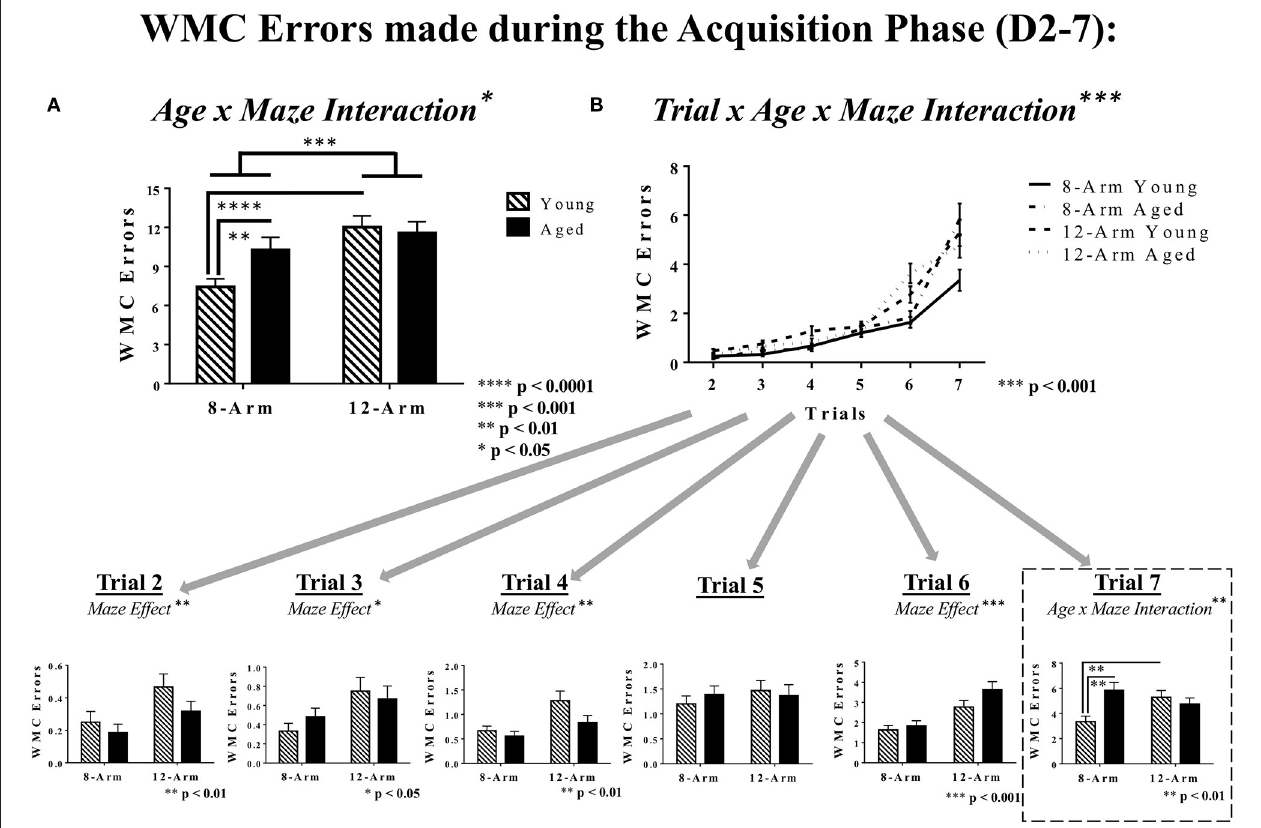
FIGURE 3 | WMC errors during the Acquisition Phase of WRAM testing. (A) WMC errors for the Acquisition Phase of WRAM testing (Days 2–7). With an effect of Maze and an Age × Maze Interaction, it was found that within the 8-Arm WRAM there was an effect of Age, but not for the 12-Arm WRAM; additionally, young rats tested on the 8-Arm WRAM performed better than those tested on the 12-Arm WRAM, but performance across maze did not differ for aged rats. (B) Working memory performance as measured by WMC errors made across all testing trials (Trials 2–7). At the highest working memory load (Trial 7), there was an Age × Maze interaction, where aged rats performing on the 8-Arm WRAM made more errors than their younger counterparts, and the rats performing on the 12-Arm WRAM did not differ by age. Additionally, for young rats there was an effect of Maze, where rats tested on the 8-Arm WRAM made fewer errors than their counterparts tested on the 12-Arm WRAM, with no effect amongst aged